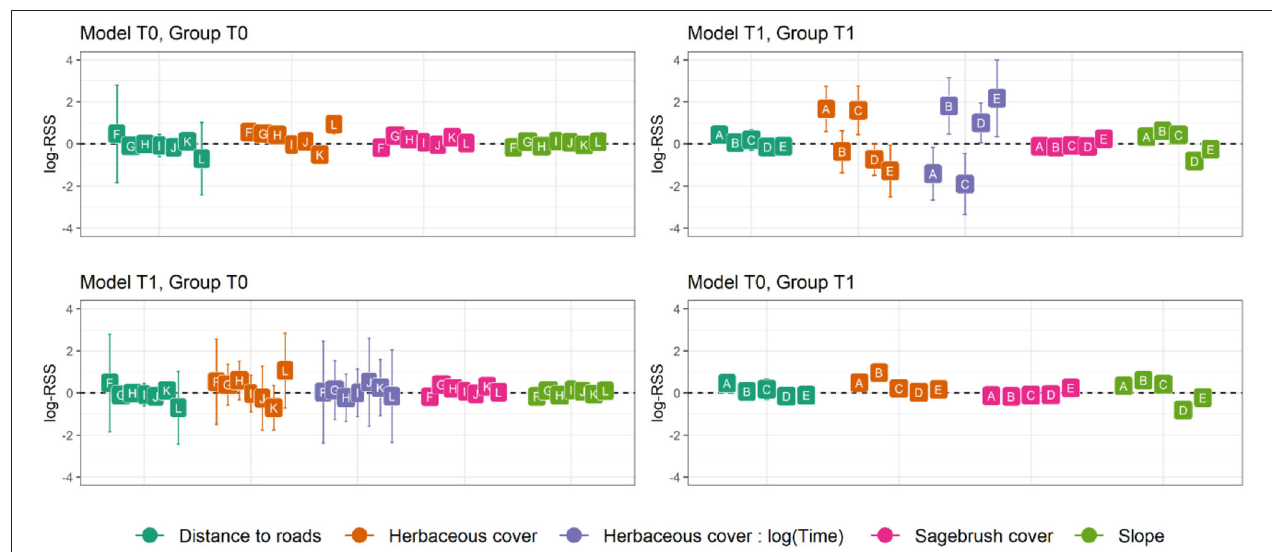
FIGURE 1 | Mean parameter estimates and 95% confidence intervals for habitat selection of translocated sage-grouse in North Dakota, 2018–2020, in the 60 days after release. Model T0 includes no time-dependent terms, while model T1 includes time-dependent selection for herbaceous cover, a key foraging resource during summer. Both models were fitted to each individual separately and ranked based on AICc, then individuals were grouped based on their top-ranked model. Individuals in group T0 had model T0 as top-ranked ( 1 AIC c > 2 for model T1), while individuals in group T1 had model T1 as top-ranked ( 1 AIC c > 2 for model T0). Parameter values express log-Relative Selection Strength ( sensu Avgar et al., 2017), i.e., the selection coefficient for a 1-unit increase in the covariate value.